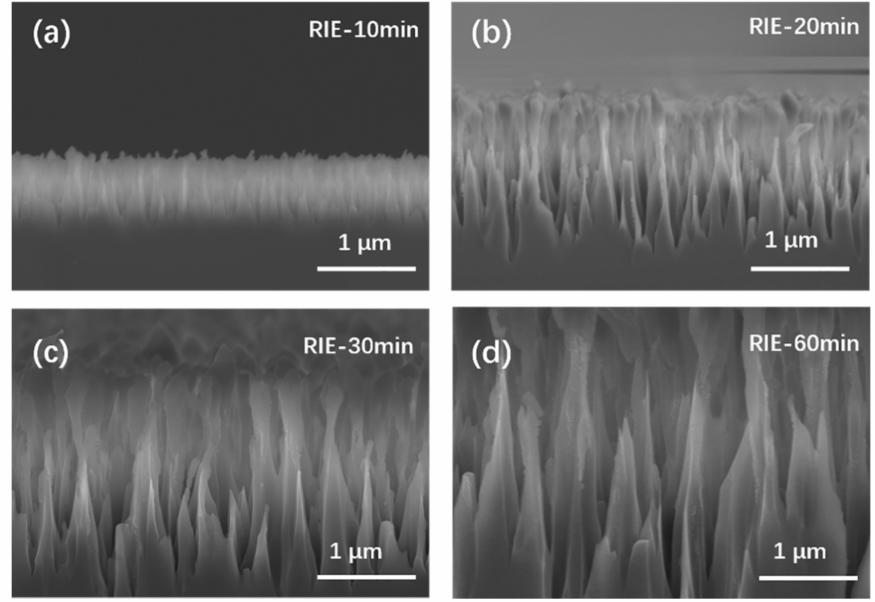
Figure A2. Cross-sectional SEM images of the silicon carbide nanoarray after RIE etching for ( a ) 10, ( b ) 20, ( c ) 30, and ( d ) 60 min, respectively. Scale bar: 1 µ